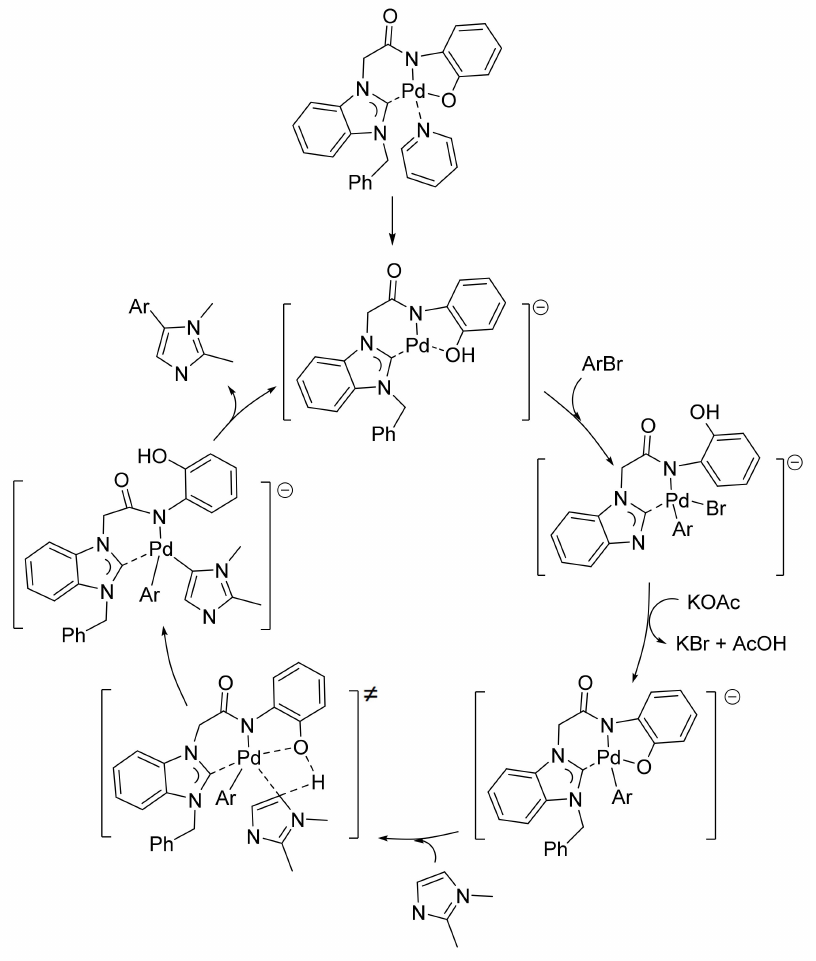
Scheme 10. Mechanism proposed by Lee and co-workers for the C-5 arylation of 1,2-